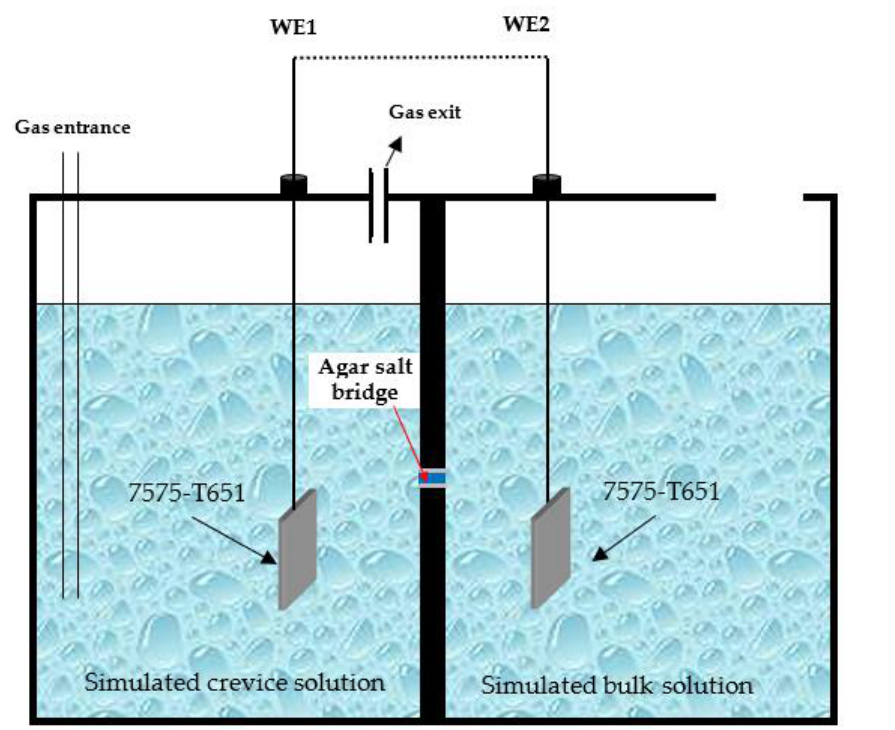
Figure 2. Schematic diagram of the two-chamber setup for corrosion morphology analysis in simu- lated crevice solution and bulk solution.